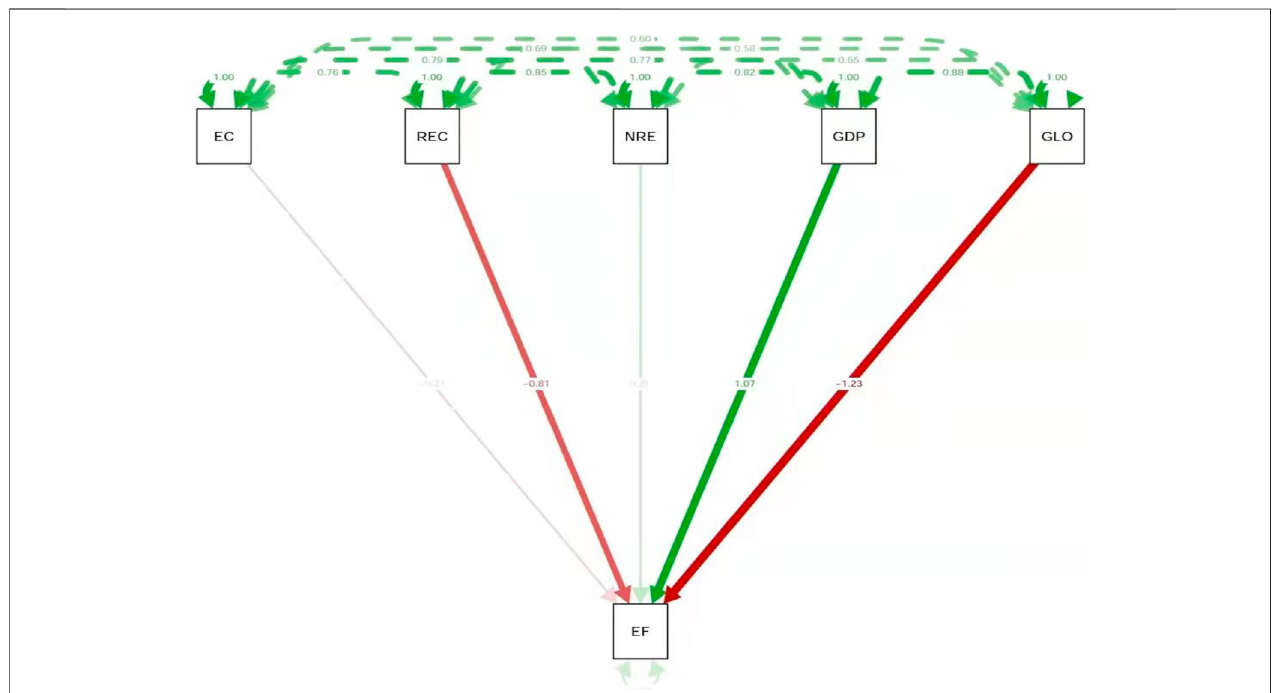
FIGURE 6 | A path diagram of how key variables impact ecological